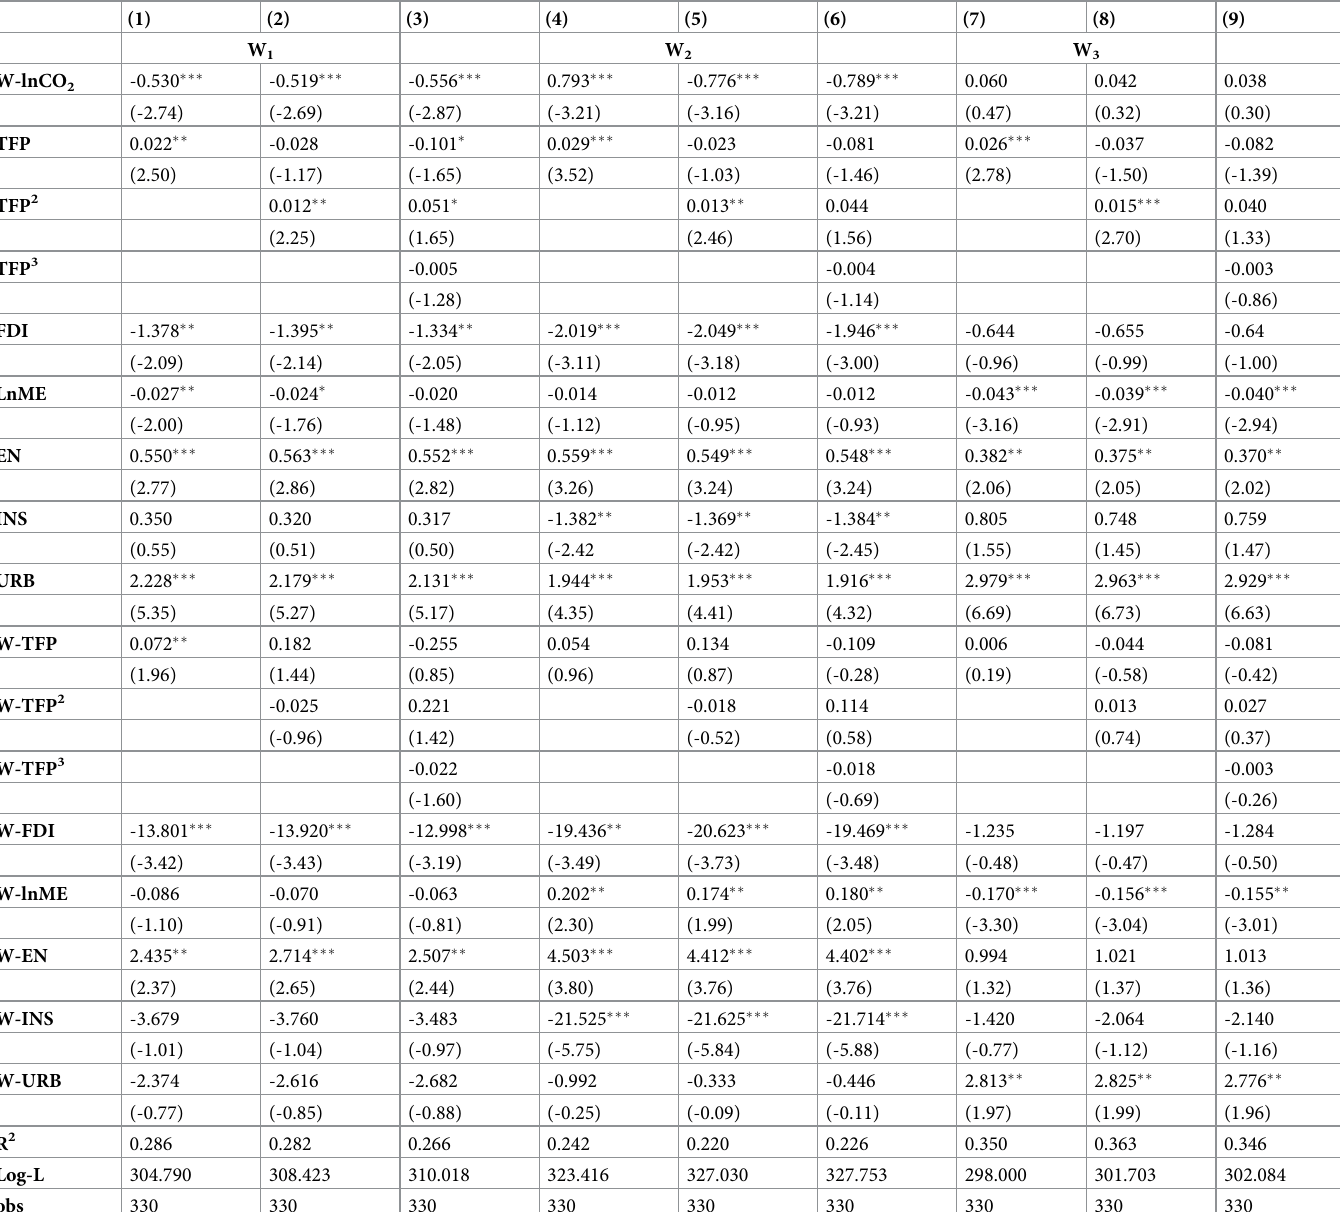
Table 9. Estimation results of